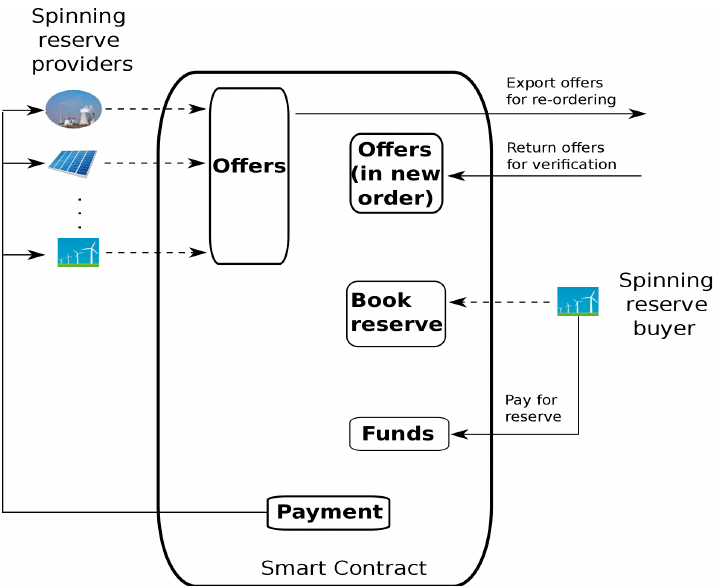
Figure 3. Systematic smart contract-based reserve trading scheme (smart contract B). Reserve sellers submit their offer to the smart contract (F3). Offers are sent out to be re-ordered and returned to the contract (F4). Buyers submit their demand (F5), as well as make payment (F6), to the smart contract which then pays successful sellers (F7).